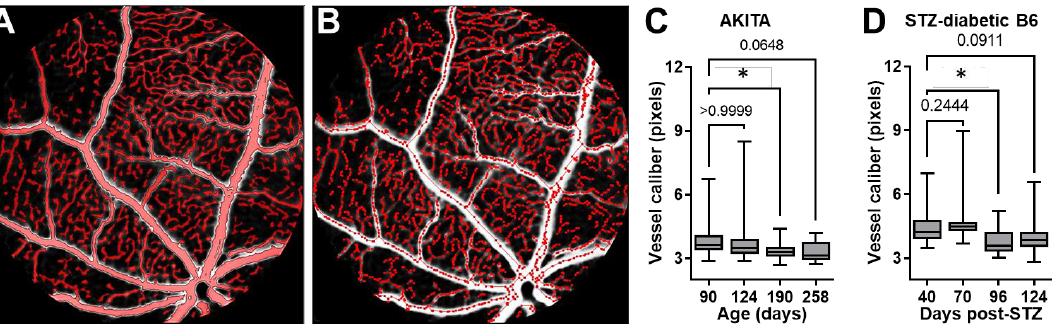
Figure 4. Changes in retinal vessel caliber during DR progression detected and quantified in longitudinal FA-DF studies. ( A ) Representative fundus image showing automatic detection and selection of retinal vessels in Volocity software based on the green fluorescence intensity in the analysis of vascular caliber (diameter). ( B ) Outline of the “skeleton” of the retinal vascular tree corresponding to the retinal vasculature detected/selected in A that was used to measure the “skeletal diameter” (vessel caliber) of all identified “objects” (vessels) within the image. (C and D) Longitudinal measurements of vessel caliber in ( C ) the diabetic AKITA mice from age 90 to 258 days ( n = 3–5 mice/time-point) and ( D ) STZ-diabetic B6 mice at 40, 70, 96, and 124 days after STZ treatment ( n = 3–8 mice/time-point). Caliber measurement units are shown in pixels since the tiff images were not calibrated for pixel size. Data are shown as Box and Whiskers with error bars representing the minima and maxima. Horizontal lines inside the boxes represent the median. Data were plotted and analyzed in GraphPad Prism. Pairwise comparisons were performed by one-way ANOVA followed by Dunnett’s multiple comparison test at each time point compared to the earliest time point in each series. Asterisk (*) denotes significance with p < 0.05, and numerical p values are shown when significance was not reached. Loss of significance at the latest time points in both models was likely due to reduced numbers of mice in association with age and increased attrition due to advanced diabetic complications.